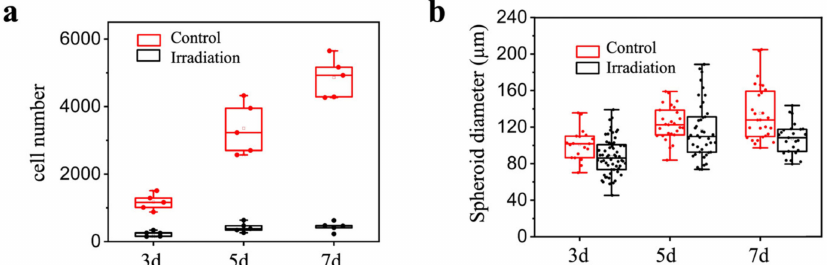
Figure 4. ( a ) Comparison of the number of cells in the control group and the irradiated group under 2D conditions. ( b ) Size comparison of MCF-7 spheroids in the control and irradiated groups under 3D conditions.